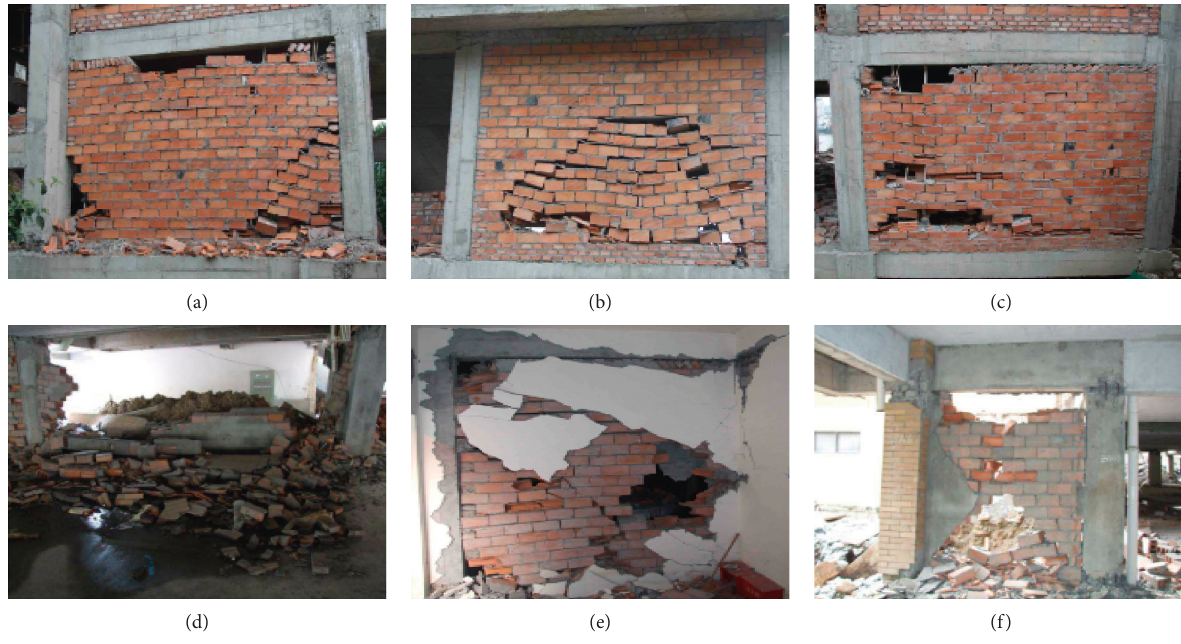
Figure 2: Damages of infilled RC frames after the 2008 Wenchuan